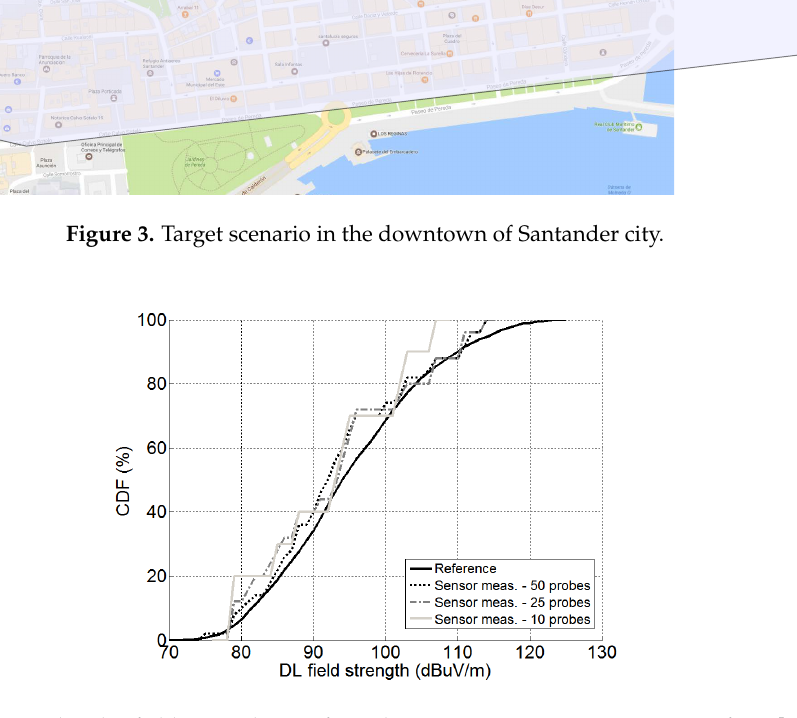
Figure 4. Simulated E-field strength CDF from dosimeter measurements. Figure 6 from [18]. Table 2. Error statistics from different dosimeter deployments